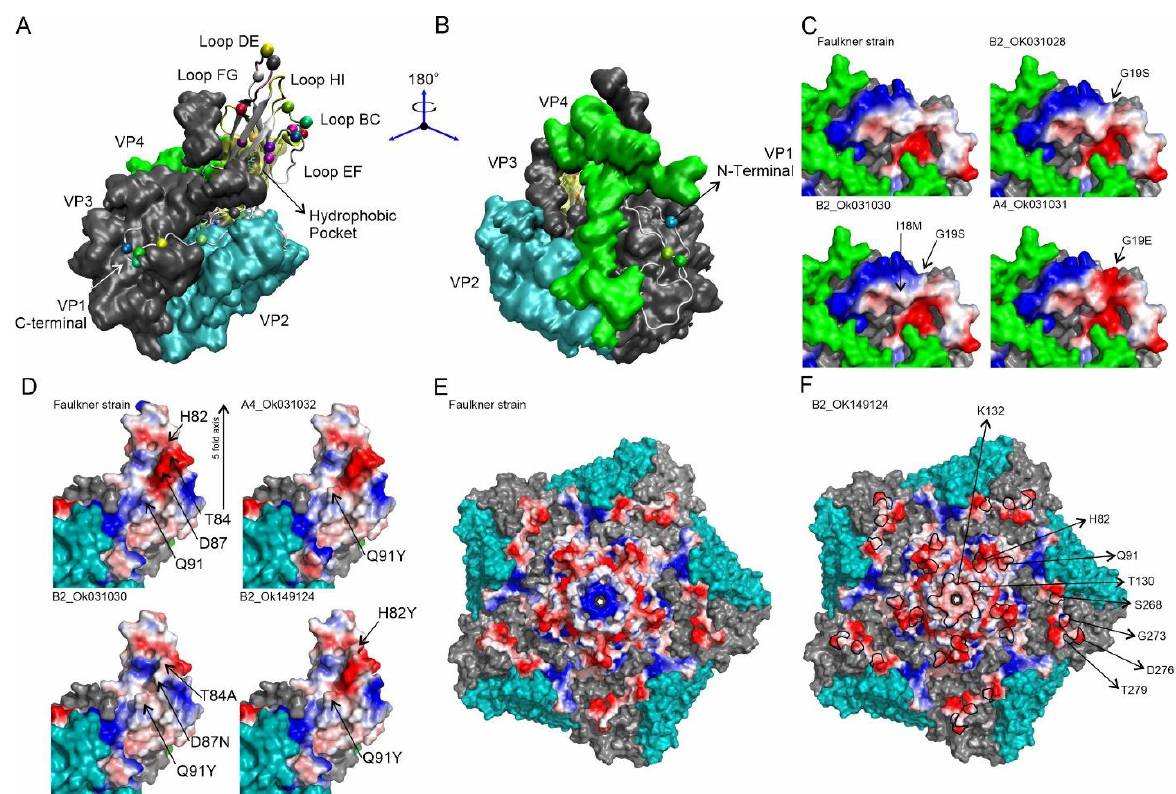
Figure 4. Structural features of VP1 in the asymmetric unit of CVB5 show the sites with modifications and how they are exposed to the virus surface. ( A ) Map of the mutations identified in Brazilian CVB5 isolates on the asymmetric unit of Faulkner prototypic strain with VP1 represented as the tertiary structure and VP2 (cyan), VP3 (gray), and VP4 (green) represented as surfaces. The interacting loops were indicated as BC-Loop (residues from 82 to 90), DE-Loop (residues from 127 to 137), EF-Loop (residues from 148 to 166), FG-Loop (residues from 172 to 177), and HI-Loop (residues from 223 to 230). The position of the hydrophobic pocket, where the palmitic acid molecule is bound, was represented as a yellow transparent surface. Mutations were represented by the residue C α atom represented as vdW sphere. ( B ) Rotation of 180° showing of the VP1 N-terminus in the capsid inner face. ( C ) VP1 N-terminus was represented as the electrostatic surface showing the Faulkner strain G19 position and representative sequences OK031028, OK031030, and OK31031, showing the substitutions G19S and the sequence I18M, G19S, and G19E. ( D ) BC-Loop was represented as the electrostatic surface showing in detail the position of the mutations and the five-fold axis, the effect of Q91Y mutation represented by OK031032, T84A, D87N, and Q91Y by OK31030 and H82Y by sequence OK149124. ( E ) The five-fold axis for the Faulkner strain, where VP1 was represented as the electrostatic surface, shows the central location of DE-Loop and the positive structural patch (blue) due to the charge of residue K132. ( F ) The five-fold axis for the sequence OK149124 shows the effect of the mutation K132Q, eliminating the central positive patch. The DE-loop is on the five-fold axis, and it shows two high-frequency substitutions in both genogroups, S125T and K132Q. T130N, T130A, and S136A are three low-frequency mutations found in genogroup B2. The mutation S125T was detected in all